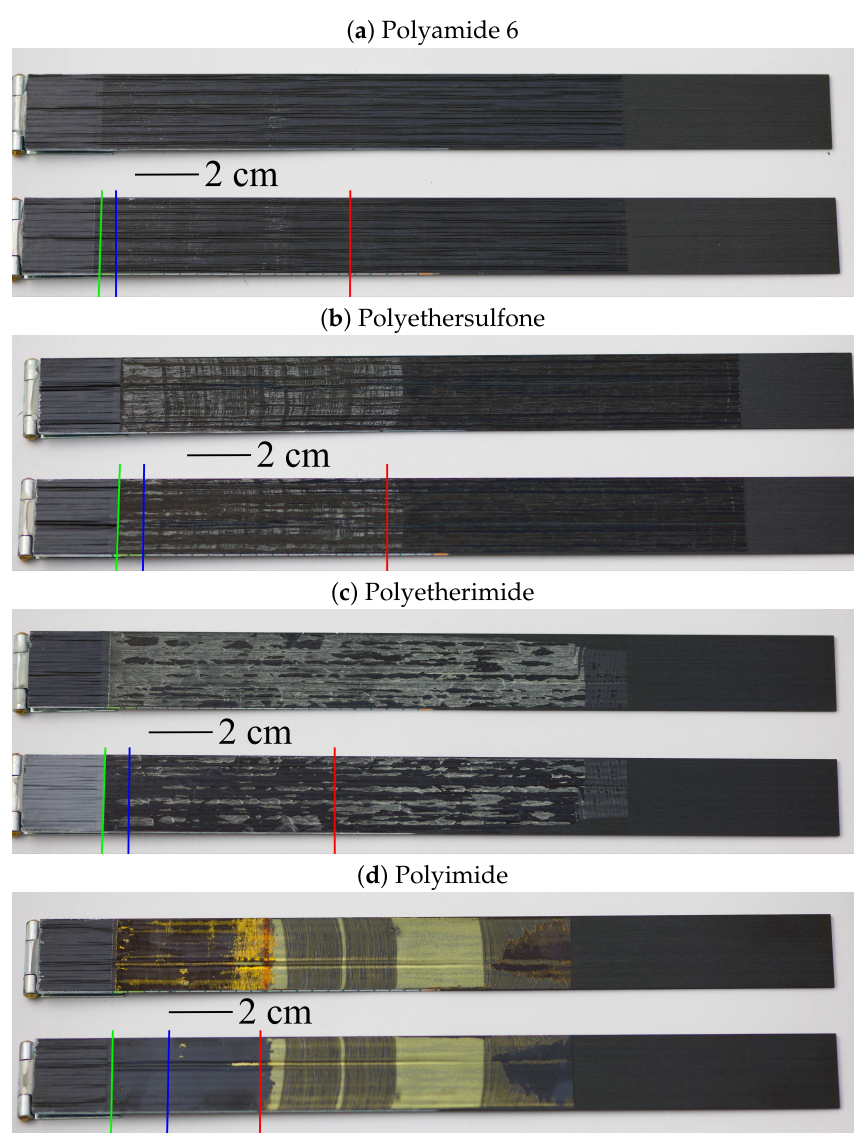
Figure 15. Fracture surfaces of DCB specimens with different thermoplastic films. The green line indicates the end of the inserted separating film, the blue line indicates the end of the precrack and the red line indicates the end of the crack after crack propagation in the